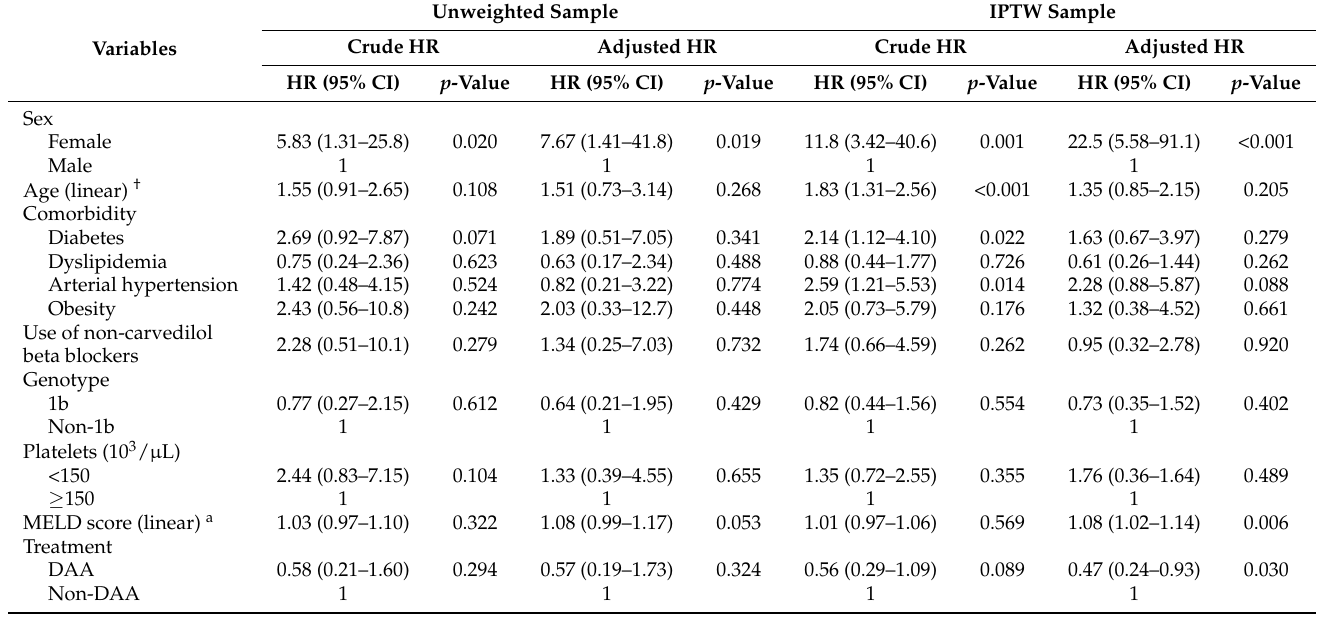
Figure 2. Kaplan-Meier plots of the EV occurrence rate ( a ) and EV progression rate ( b ).